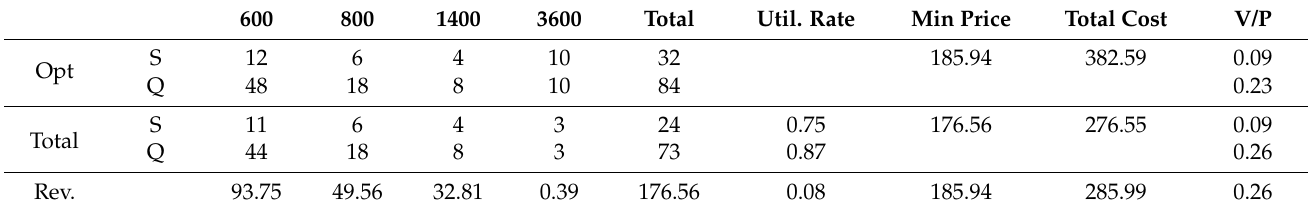
Table 13. Result of Simulated Annealing and Random Optimization.